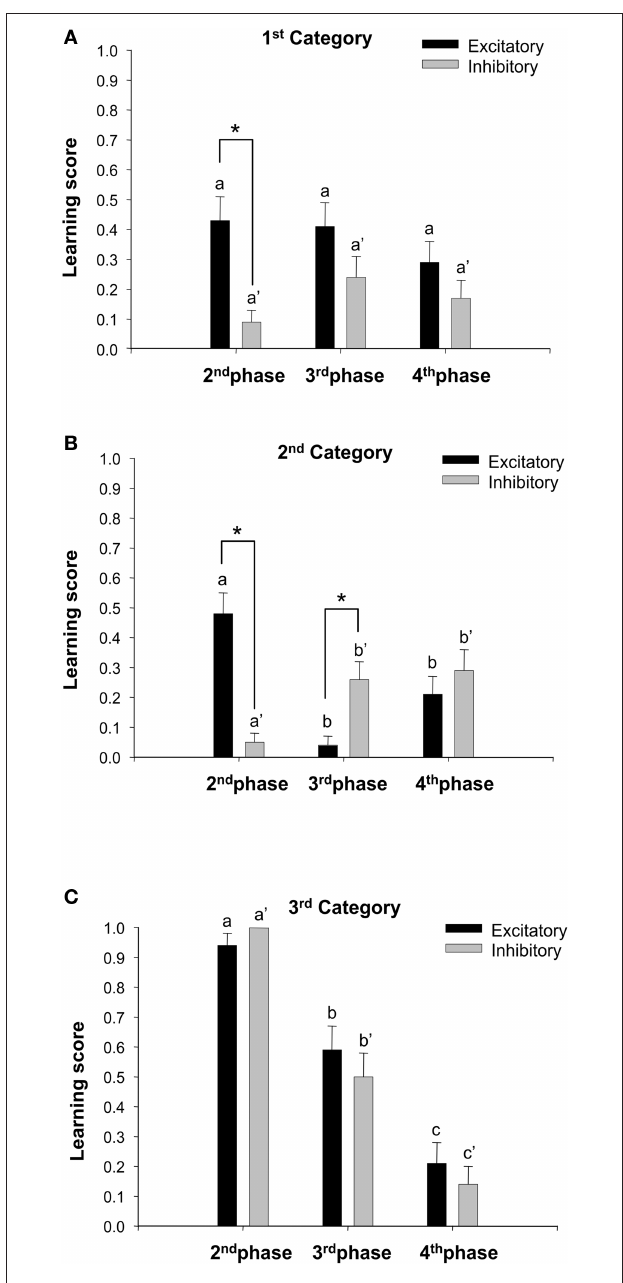
Figure 5 | Average excitatory ( ∆ ) and inhibitory ( ∆ ) reversal learning e i scores ( + S.e.) computed for the three categories of bees, for the three reversal phases (2nd, 3rd, and 4th conditioning phases). (A) First category ( n = 35 bees) included individuals that were not able to solve the very first discrimination of the 1st phase (A + vs. B − ). (B) Second category ( n = 42 bees) included individuals that mastered the very first discrimination, but were unable to solve the subsequent reversal discrimination of the 2nd phase (A − vs. B + ). (C) Third category ( n = 34 bees) included individuals that solved the discriminations of the 1st and the 2nd phase, for which, therefore, the question of success in further reversal learning (3rd and 4th phases) was pertinent. Statistical comparisons of excitatory scores between phases are indicated by letters (e.g., a, b). Comparisons of inhibitory scores between phases are indicated by letters with prime (e.g. a ′ , b ′ ). Asterisks indicate significant difference between excitatory and inhibitory scores within a